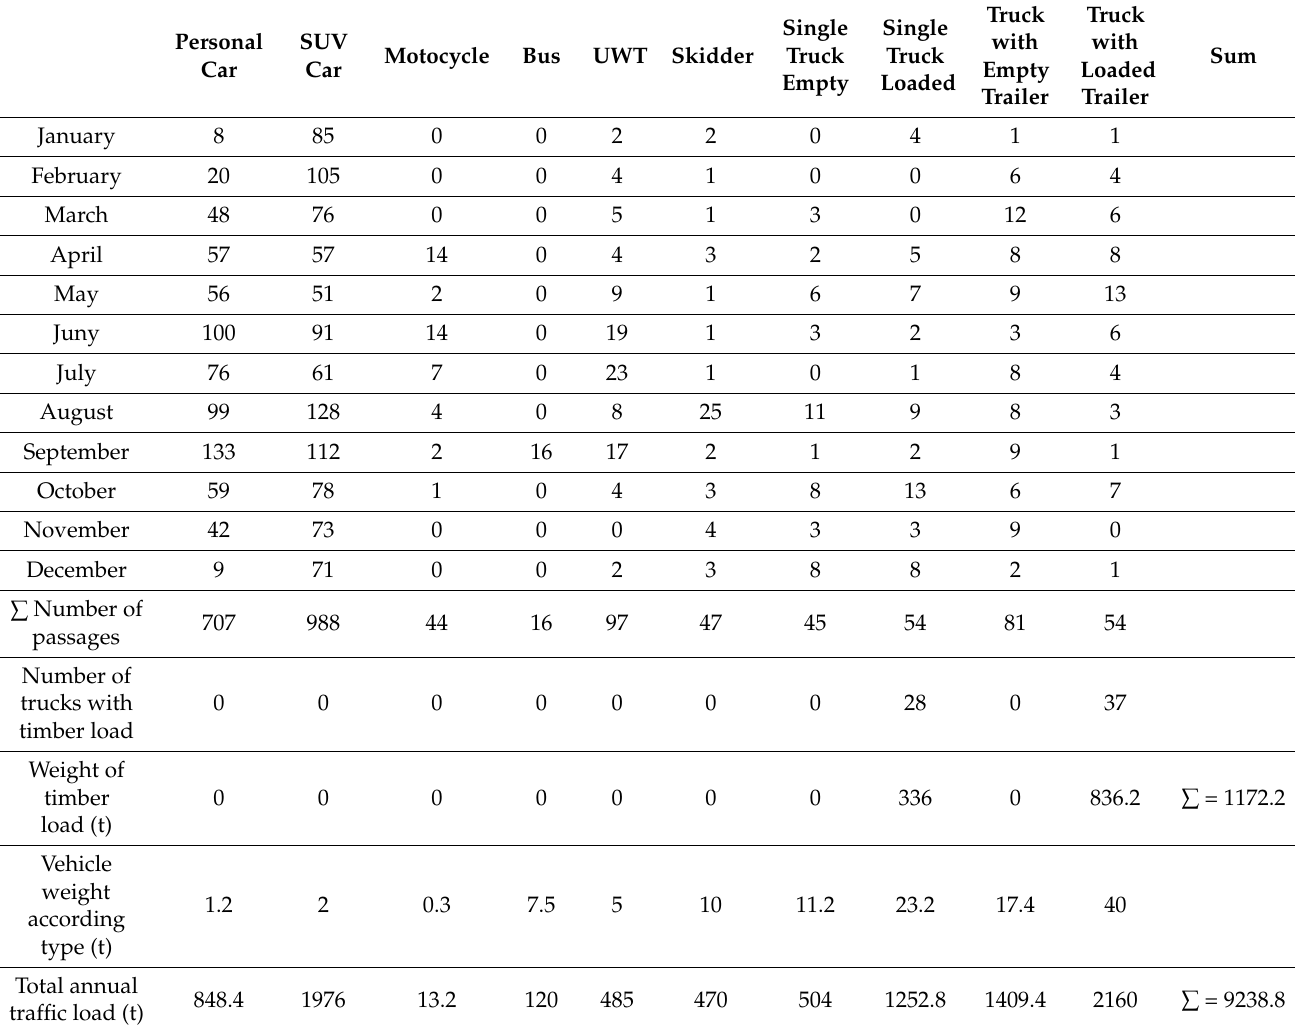
Table 5. Traffic load at A locality in the year